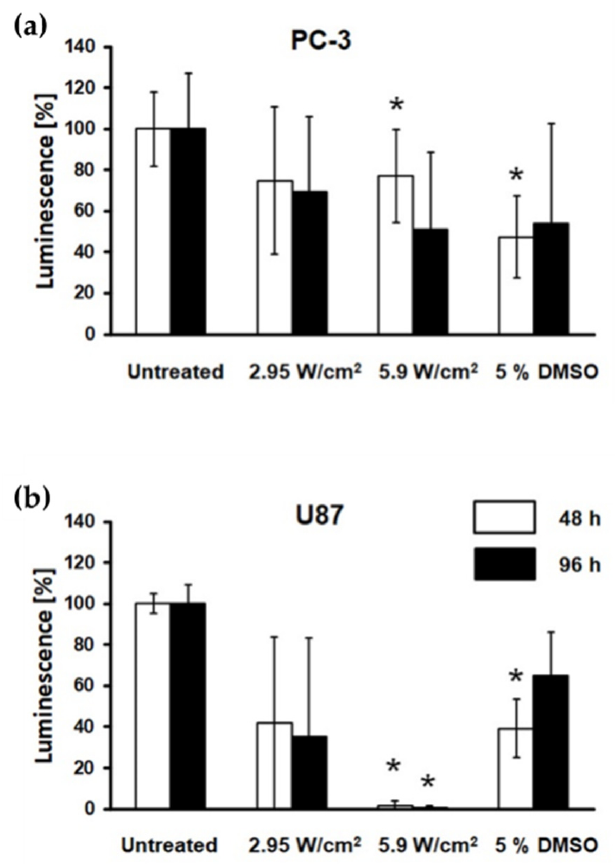
Figure 5. FUS diminished spheroid metabolic activity. ATP content of PC-3 ( a ) and U87 ( b ) spheroids was assessed using CellTiter-Glo ® 3D Cell Viability assay 48 and 96 h after treatment, showing the reduction of cell metabolic activity. Data sets were normalised to the untreated control group (100%), while data analysis was carried out by one-way ANOVA. * Significantly different from the untreated group ( p ≤ 0.05). n = 9.